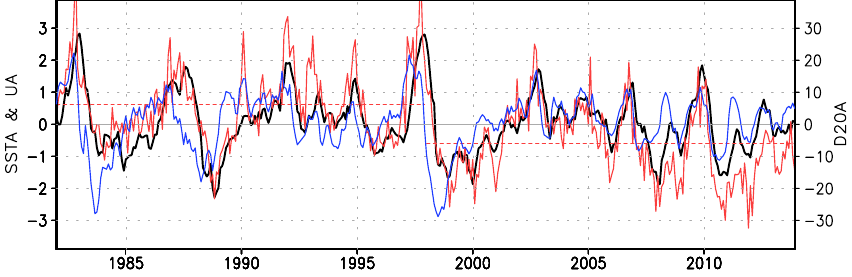
Figure 1. Observed ENSO-related SST (°C), zonal wind (m/s), and 20°C isotherm depth (D20, meter) anomalies during 1982–2013. The black line denotes the SST anomalies in Nino3.4 region (5°S–5°N, 170°W–120°W). The blue line indicates the warm water volume index 39 , represented by the D20 anomalies averaged in the equatorial Pacific basin (5°S–5°N, 150°E–90°W). The red sloid line displays the zonal wind anomalies in the central Pacific Ocean (5°S–5°N, 150°E–160°W). The dashed red lines denote the mean zonal wind anomaly of the period 1982–1997 and 1998–2013, respectively. This figure is created using Grid Analysis and Display System (GrADS) Version 2.0.2 (http://cola.gmu.edu/grads/).